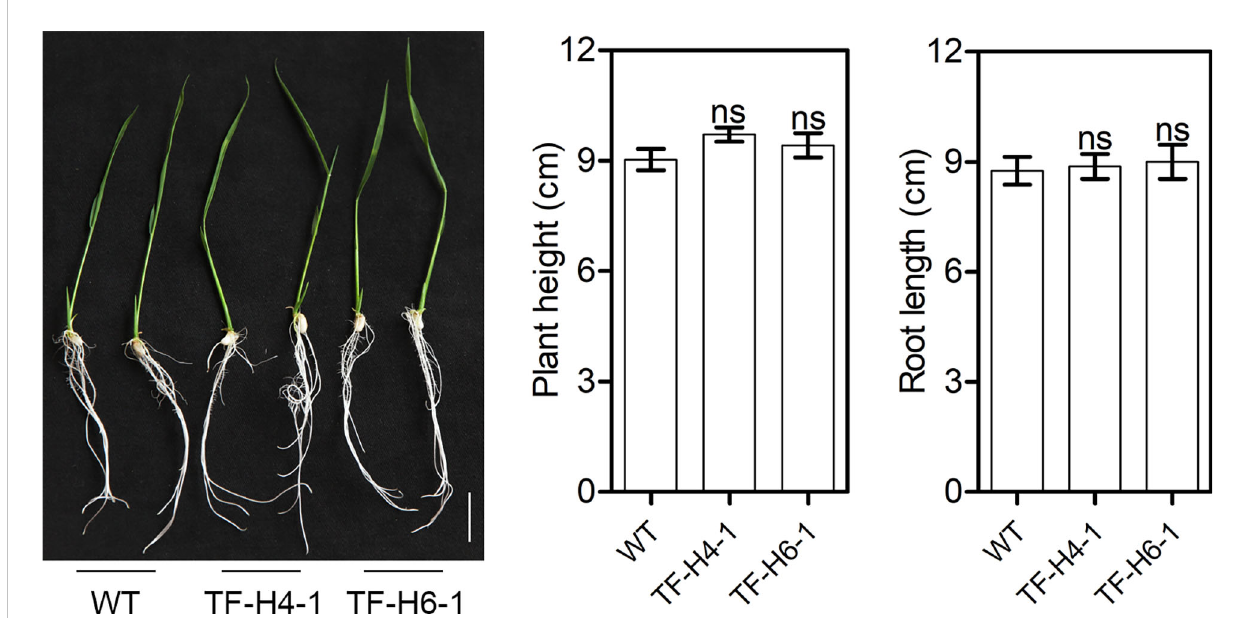
FIGURE 5 Growth phenotypes of ‘ transgene-free ’ OsHPP04 knockout rice at 10 day after germination. Bars = 5 cm. Data were analyzed by a two-tailed Student ’ s t-test (ns P > 0.05. Values are mean ± SE ). WT: wild-type rice; TF-H4-1 and TF-H6-1: two ‘ transgene-free ’ OsHPP04 mutant lines.